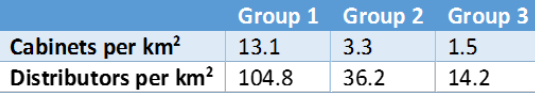
Table 1. Average density of distributors for each